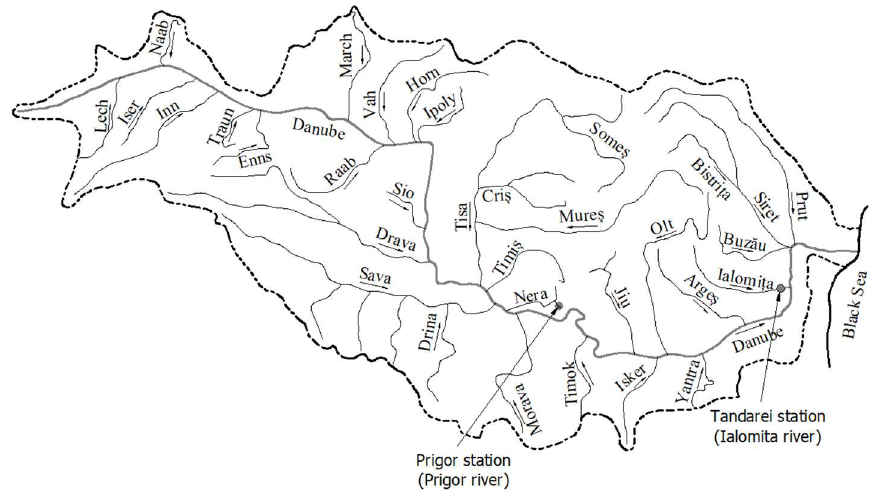
Figure 2. Location map of Study areas: Prigor and Ialomita rivers, Romania.